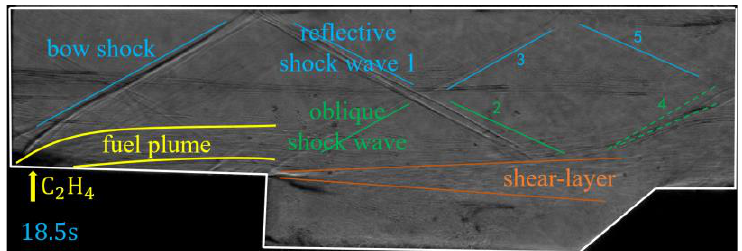
Figure 6. Shadowgraph at Case 9, 1 — Reflected shock wave, 2 — Intersecting shock waves, 3 — Intersecting shock waves, 4 — Reflected expansion wave, 5 — Reflected shock wave.